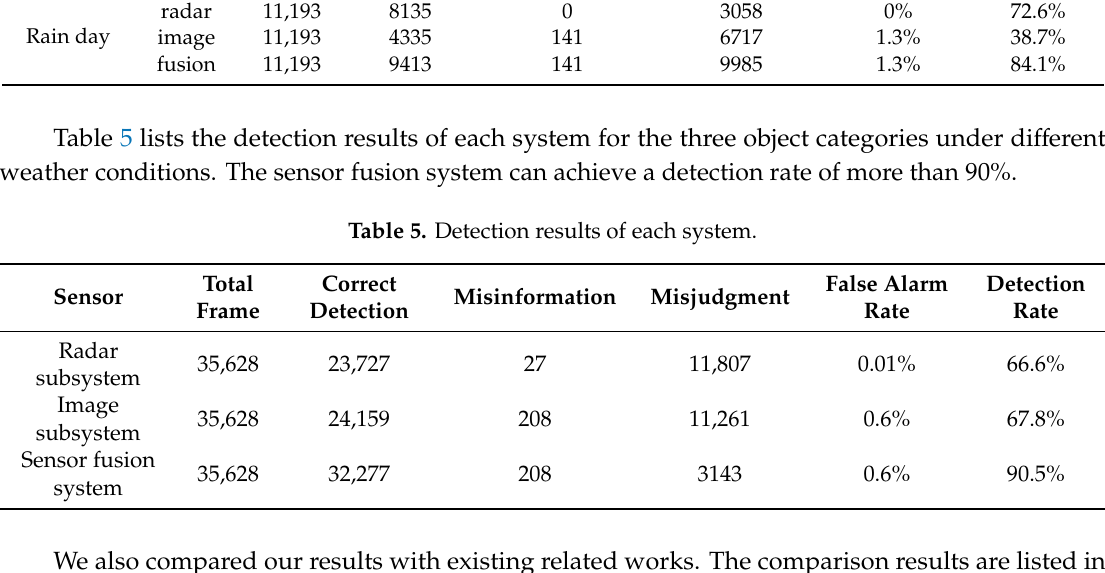
Table 4. Detection results of each system under different weather conditions.